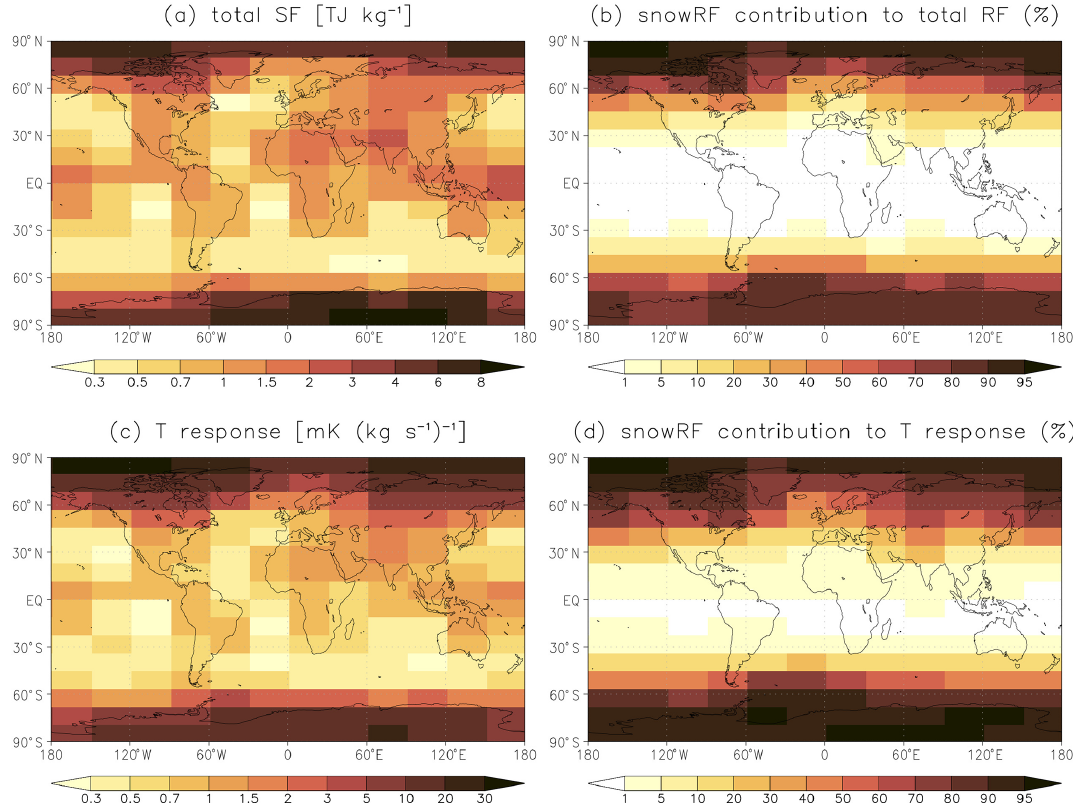
Figure 7. (a) Global mean BC total SF, defined as the sum of dirSF and snowSF (TJkg − 1 ). (b) The fractional contribution of snowRF to the total RF (or, equivalently, to the total SF; %). (c) Estimated global mean temperature response normalized by the BC emissions (mK(kgs − 1 ) − 1 ). (d) The fractional contribution of snowRF to the temperature response (%). This figure is based on the experiments in which uniform BC emissions over the year were assumed separately for emissions in 192 lat–long